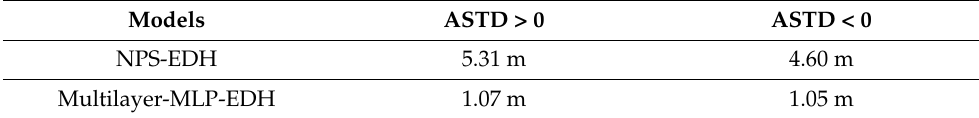
Table 6. The statistical RMSEs in different conditions.